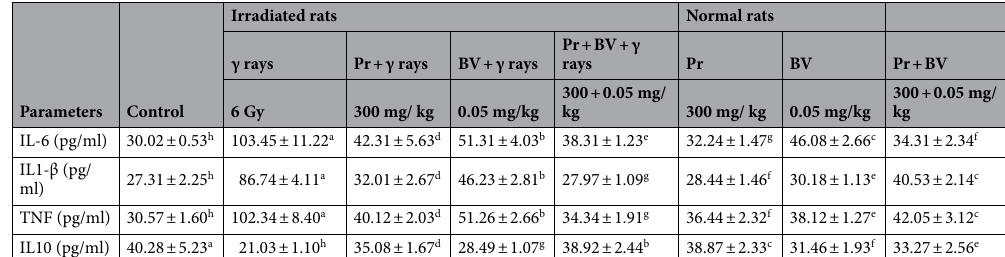
Table 4. Effect of propolis and/ or bee venom on cytokines. Values with same superscript in the same raw are not statistically different. Data expressed as mean ± SE, n = 6. The groups are statistically significant (P < 0.05) as compared with control, using one-way ANOVA followed by Duncan’s test as a post-hoc test.